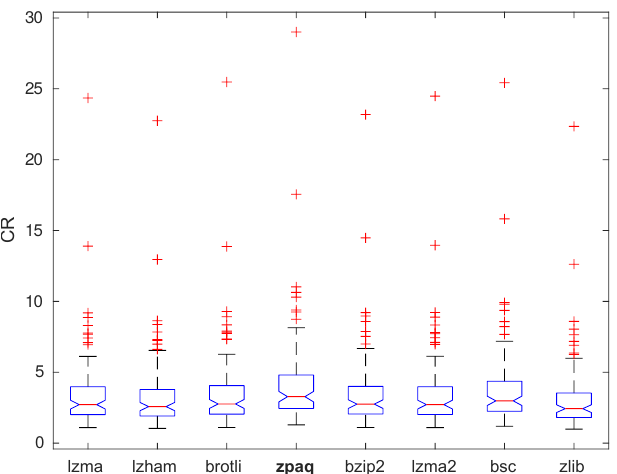
Figure 4. Compression ratio boxplots for eight compression methods run on 100